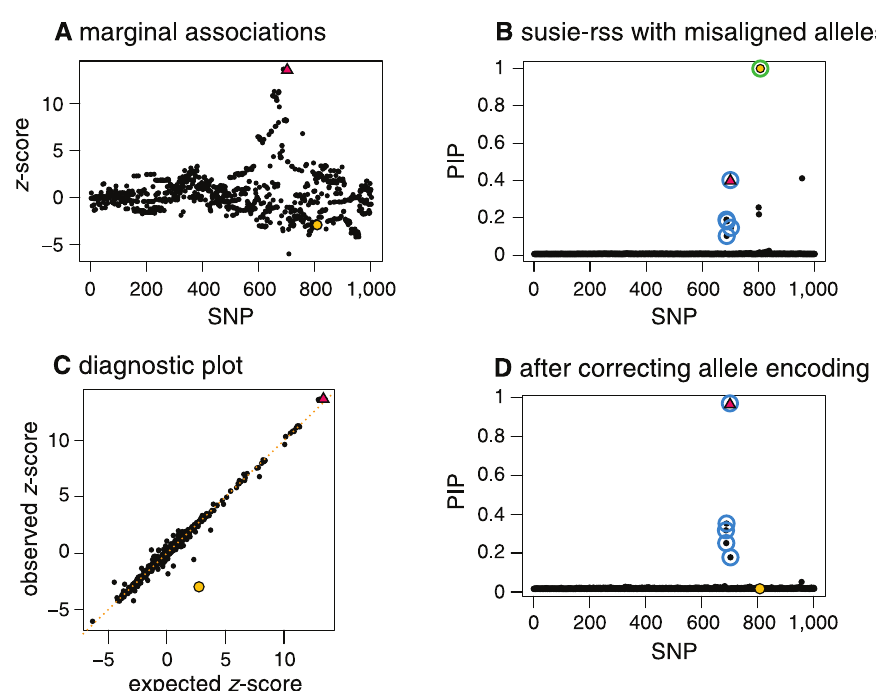
Fig 1. Example illustrating importance of identifying and correcting allele flips in fine-mapping. In this simulated example, one SNP (red triangle) affects the phenotype, and one SNP (yellow circle) has a different allele encoding in the study sample (the data used to compute the z -scores) and the reference panel (the data used to compute the LD matrix). Panel A shows the z -scores for all 1,002 SNPs. Panel B summarizes the results of running SuSiE-RSS on the summary data; SuSiE-RSS identifies a true positive CS (blue circles) containing the true causal SNP, and a false positive CS (green circles) that incorrectly contains the mismatched SNP. The mismatched SNP is also incorrectly estimated to have an effect on the phenotype with high probability (PIP = 1.00). The diagnostic plot (Panel C) compares the observed z -scores against the expected z -scores. In this plot, the mismatched SNP (yellow circle) shows the largest difference between observed and expected z -scores, and therefore appears furthest away from the diagonal. After fixing the allele encoding and recomputing the summary data, SuSiE-RSS identifies a single true positive CS (blue circles) containing the true-causal SNP (red triangle), and the formerly mismatched SNP is (correctly) not included in a CS (Panel D). This example is implemented as a vignette in the susieR